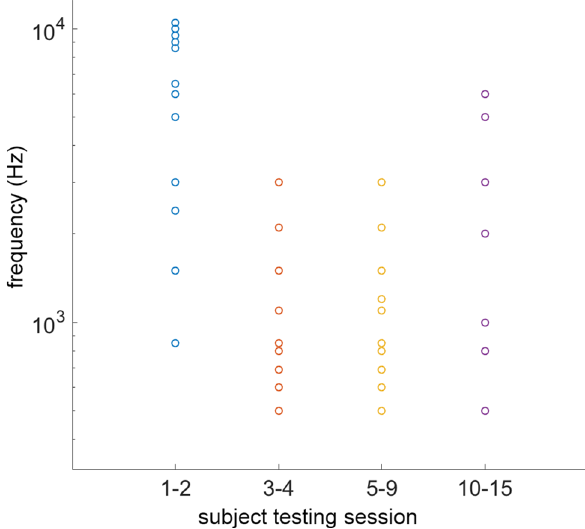
Figure 7. The figure shows the maximum number of channels used during the testing sessions. Each circle represents a channel used to deliver the processed neural recordings across. The frequency of that channel corresponds to the characteristic frequency (CF) of the originally recorded neural single unit. A channel is defined here as an electrode contact with the most basal contact corresponding to electrode 1 and the most apical contact corresponding to electrode 16. For testing sessions 1–4, the frequencies, from lowest to highest, were played to electrodes 1, 2, 3, 4, 6, 7, 8, 10, 11, 12, 13 and 14. For words that required less than 12 channels, the most apical (i.e., highest frequency) channels were removed. For testing sessions 5 to 9, the frequencies were played to electrodes 1, 2, 3, 4, 6, 7, 8, 10, 11 and 12. Once again, for words requiring fewer channels, the most apical channels were removed. For session 10, all words were played across only six channels played to electrodes 1, 6, 7, 11, 13, and 15. Finally, for the remaining testing sessions, 11–15, all words were played across 15 channels corresponding to electrodes 2 to 16. The final frequency map used for testing in sessions 10 to 15 was closest to the standard AB patient map used in our subjects’ current